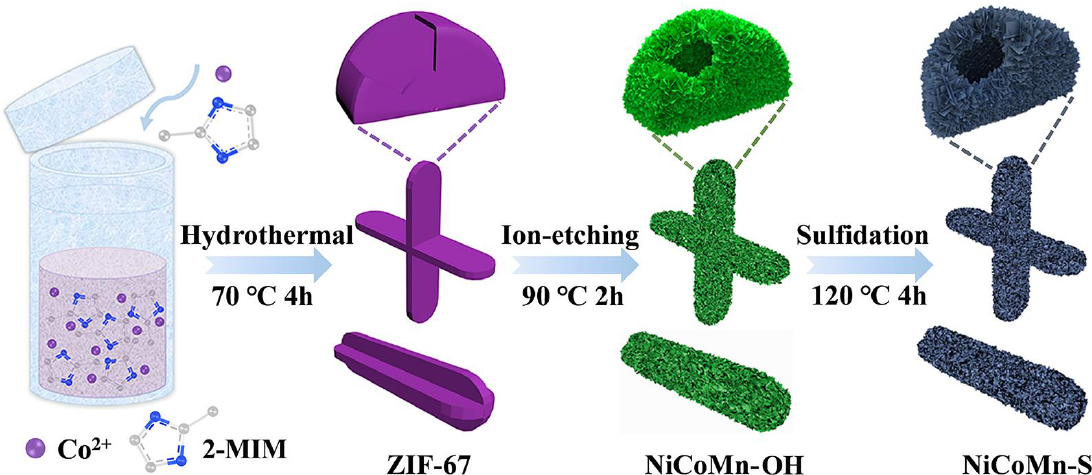
Figure 5. The preparation process of hollow rod-like NiCoMn-S ternary metal sulfide [52]. Copyright 2022 Elsevier.